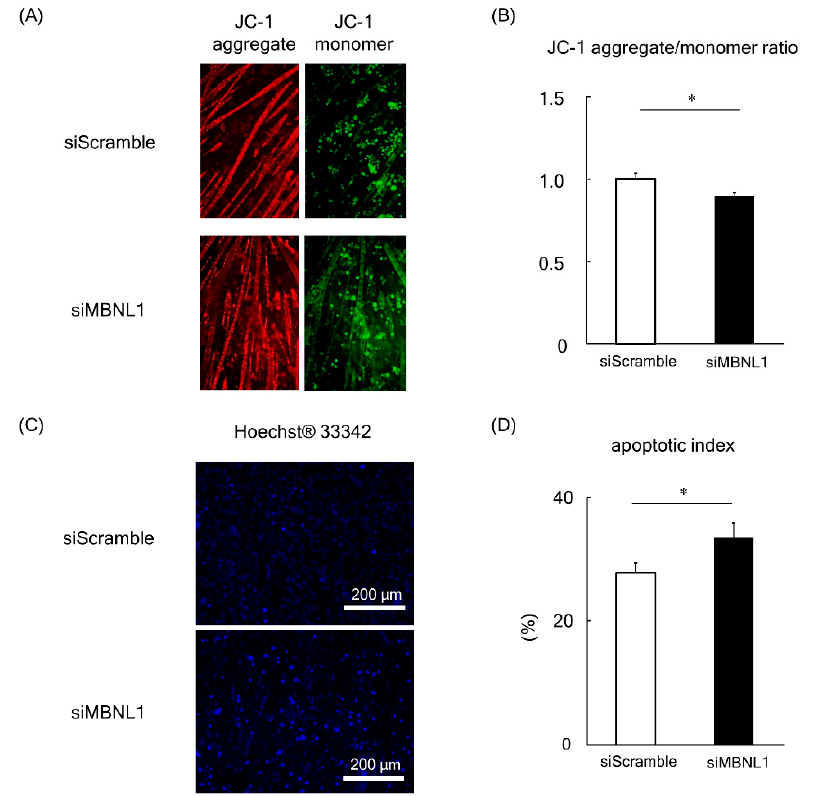
Figure 5. Effects of MBNL1 knockdown on mitochondrial membrane potential and apoptosis in C2C12 myotubes. Typical images of C2C12 myotubes stained by JC-1 ( A ) and Hoechst 33342 ( C ). ( B ) The red/green fluorescence intensity ratio of JC-1. ( D ) Apoptotic index, the ratio of apoptotic nuclei to normal nuclei. Abbreviations are the same as in Figure 1. Values are means ± SEM; n = 6 per group. *: p < 0.05.